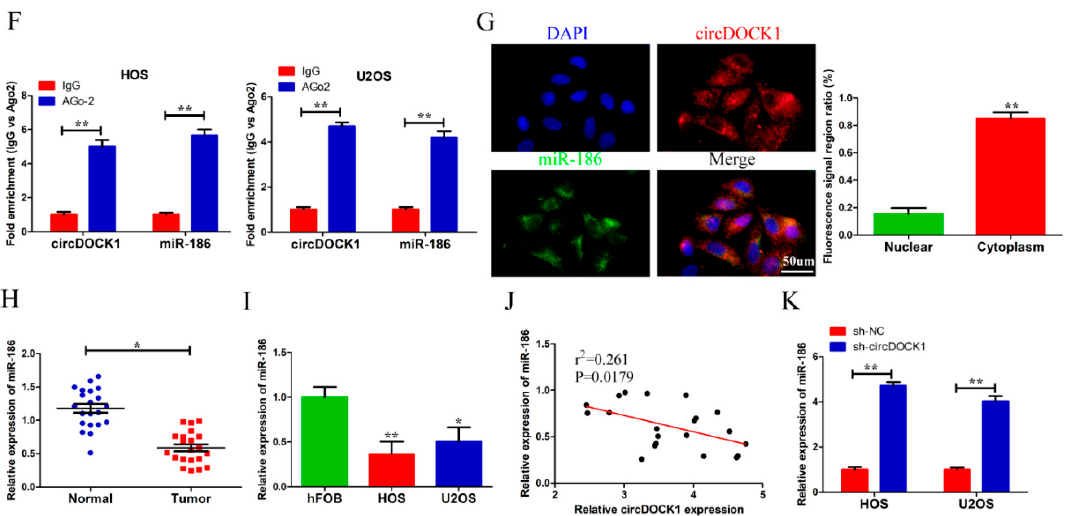
Figure 3. CircDOCK1 acts as a sponge for miR-186. ( A ) Bioinformatics analysis outcomes predicting the circDOCK1 targets. ( B ) The expressions of two target miRNAs in OS cell lines. ( C ) Luciferase activity of the circDOCK1 reporter after transfection of sh-circDOCK1 in OS cells. ( D ) The circDOCK1–miR-186 binding sites were predicted using bioinformatics, and the red sequence means mutant binding sequences. ( E ) Luciferase activity outcome on co-transfected OS cells. ( F ) RIP assay outcome on the binding correlation of circDOCK1 with miR-186. ( G ) FISH assay outcome suggests the cytoplasmic co-localization of circDOCK1 and miR-186. ( H , I ) The OS tissue and cellular levels of MiR-186 were markedly decreased. ( J ) The miR-186 level was negatively regulated by circDOCK1. ( K ) Silencing circDOCK1 increased miR-186 expression. * p < 0.05, ** p < 0.01.